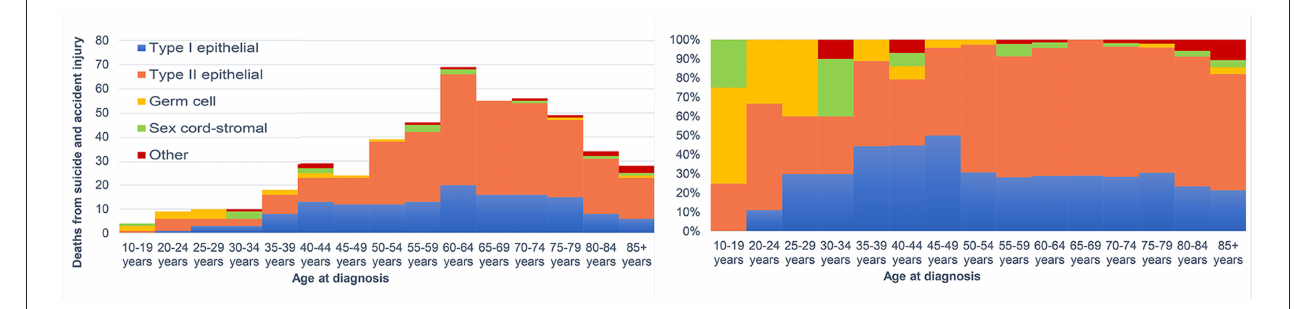
FIGURE 3 | The number of suicides and accidental death among patients with ovarian cancer by age at